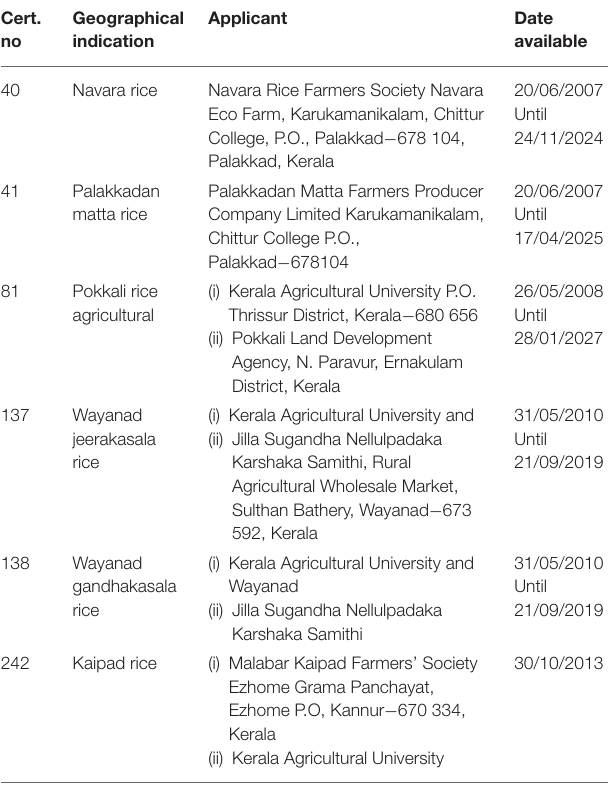
TABLE 2 | Registered Geographical Indications of Traditional Rice from Kerala. Cert.